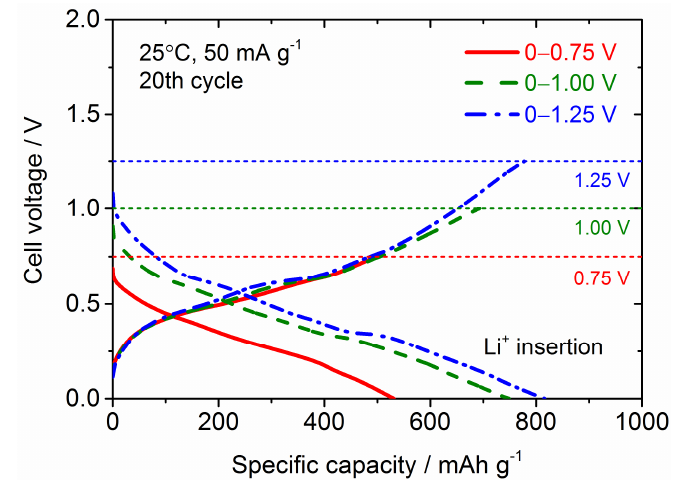
Figure 10. Comparison of galvanostatic charge (Li + insertion) and discharge (Li + extraction) curves at the 20th cycle for the Sn 4 P 3 /C composite film electrode tested at different cell voltage windows.